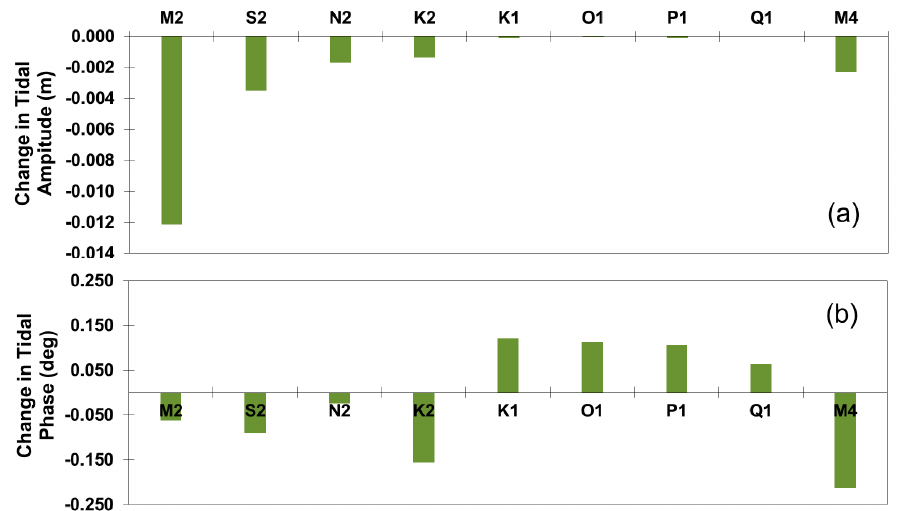
Figure 14. The changes in tidal amplitude ( a ) and phase ( b ) at the NOAA tidal gage near Anchorage, Alaska, as a result of power extraction in S2.